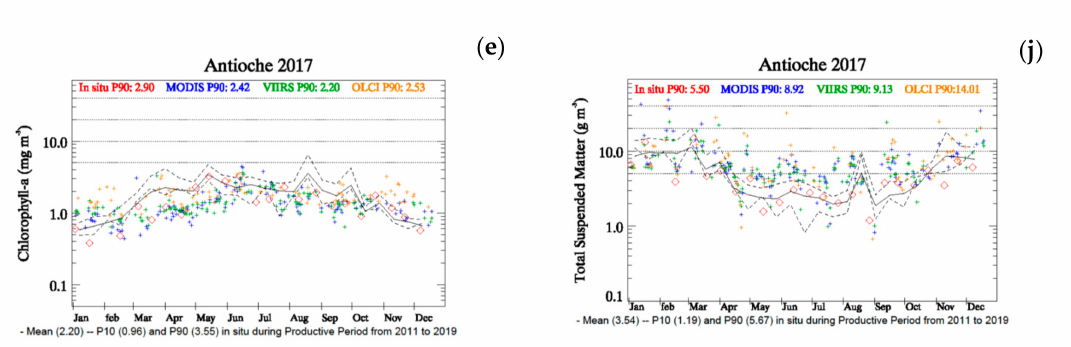
Figure 8. Chl- a ( a – e ), Turbidity ( f – i ) or TSM ( j ) in the Bay of Biscay. In situ and satellite percentiles of year 2017 are indicated in the upper part of the graphs; the in situ historical mean, P10 and P90, calculated over the productive period, are indicated under the time axis.